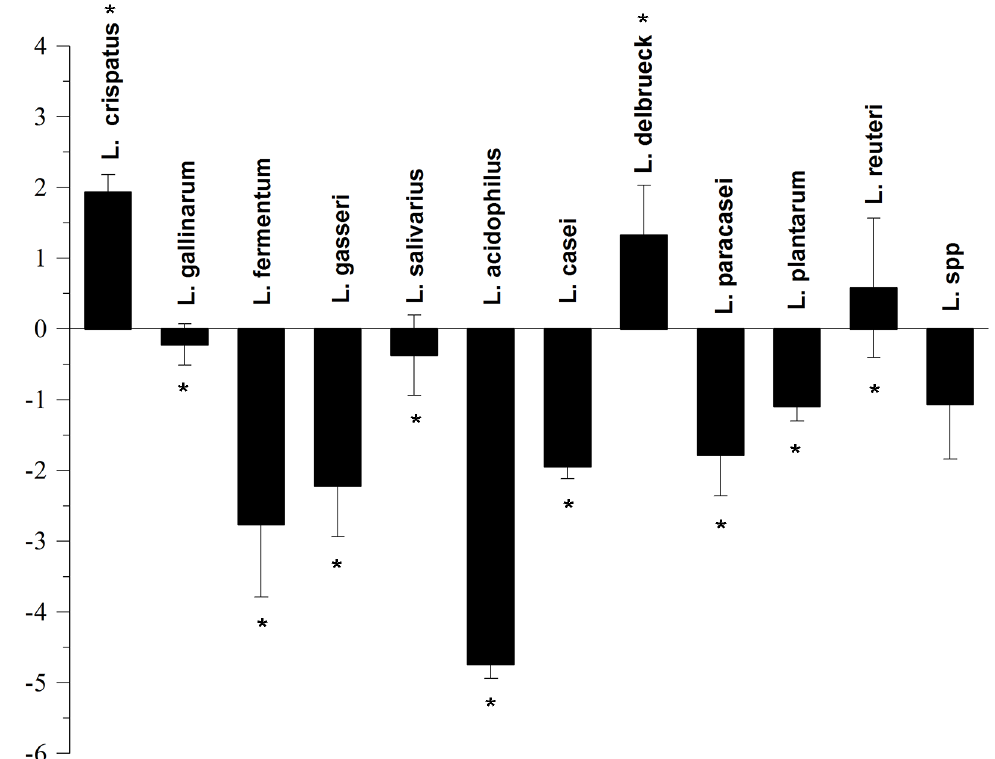
Fig 1. The relative quantification of Lactobacillus species in UC patients. The fold change was calculated using log 10 RQ where RQ is 2 − ΔΔ Ct . Statistical significance was determined by a t -test comparing Δ Ct of healthy controls to Δ Ct of UC patients. * P < 0.05.